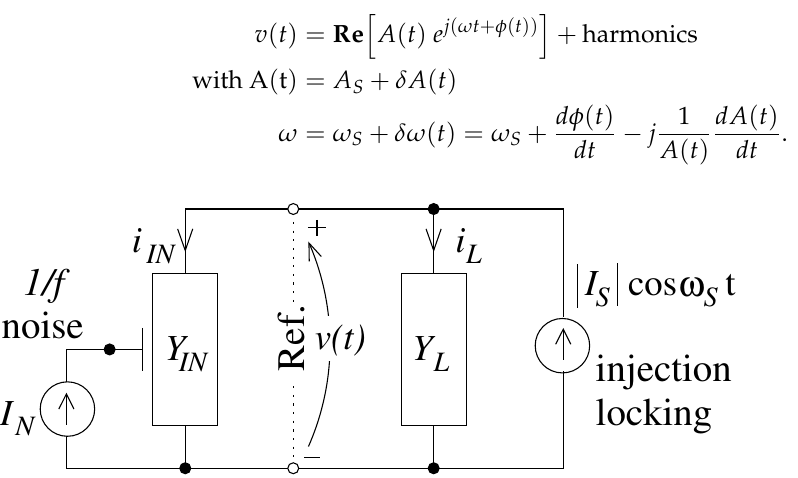
Figure 1. Admittance model for one-port injection-locked